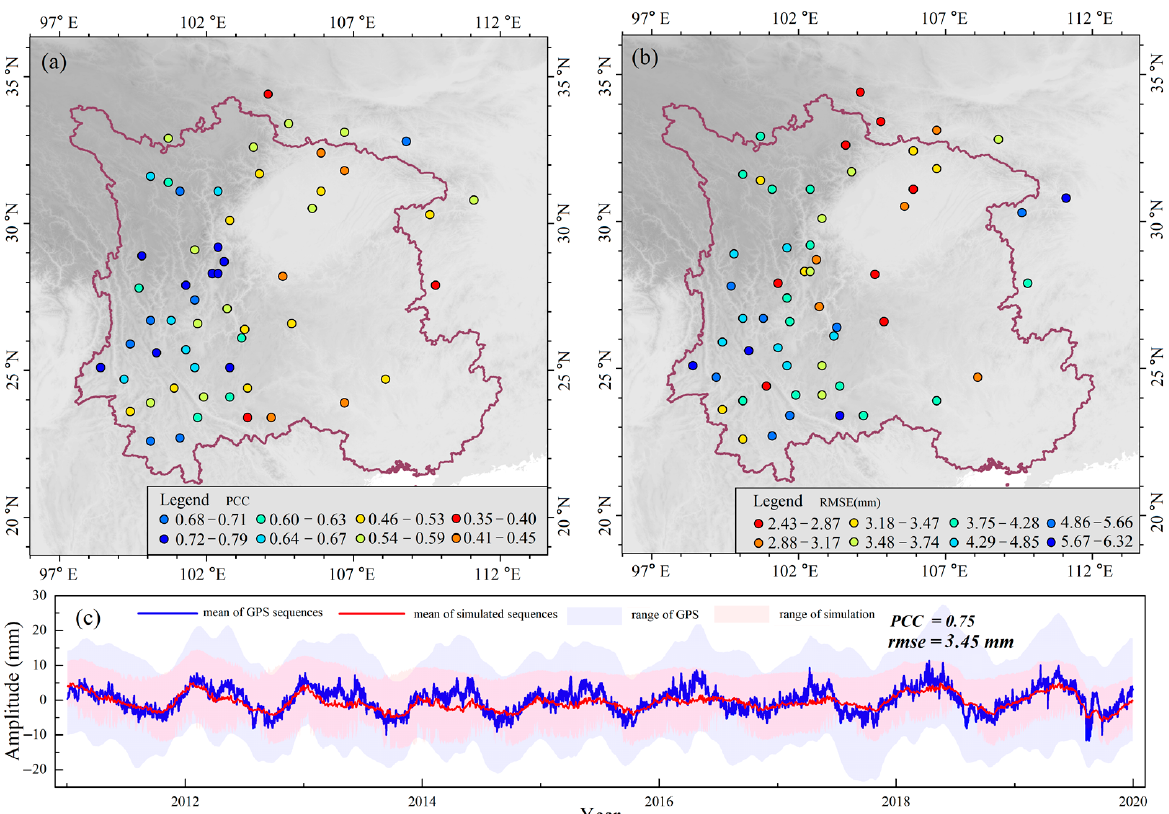
Figure 5. The regressed result of crustal deformation based on RF with PCC ( a ) and RMSE ( b ). Figure 5 shows that the crustal deformation can be simulated effectively by this simulated method. According to the statistics in Figure 5a, 84.21% values of PCC are more than 0.5, with the maximum value of 0.79. The dispersion degree between the simulated sequences and the real sequences performs well, which can be determined by RMSE (Figure 5b). The 68.42% values of RMSE are less than 5 mm, and the value of RMSE is related to the quality of the GPS sequence. To verify the reliability of the simulation of crustal deformation, the mean simulated, and true sequences are obtained, respectively. Figure 5c indicates that the MLLIM can effectively simulate the periodic term and amplitude of the sequences with the PCC of 0.75, with RMSE of 3.45 mm, respectively. Thus, the GPS vertical deformation sequence can be simulated by this method in the unobserved